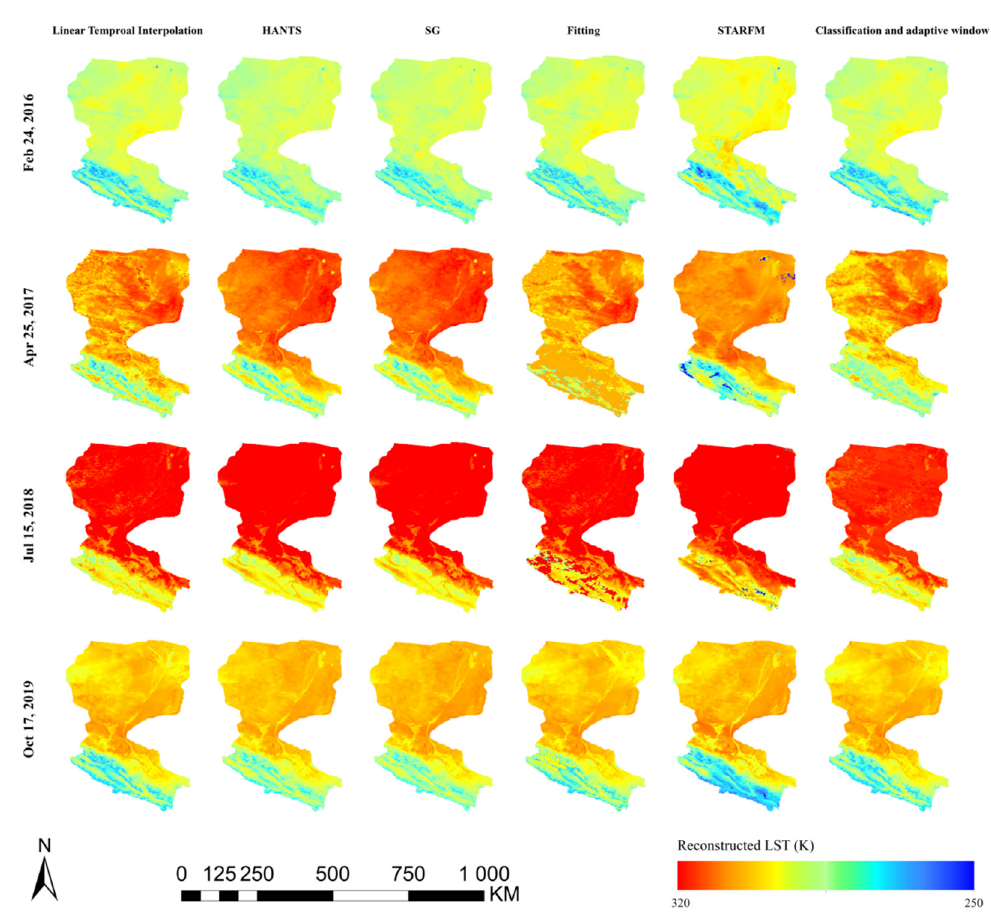
Figure 8. Spatial distribution of the reconstructed LST based on temporal, spatial, and spatiotemporal methods from 2016 to 2019.